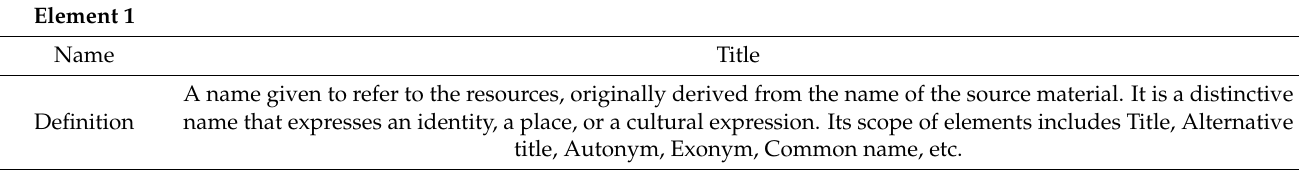
Table 2. Description of SAC’s common metadata elements.